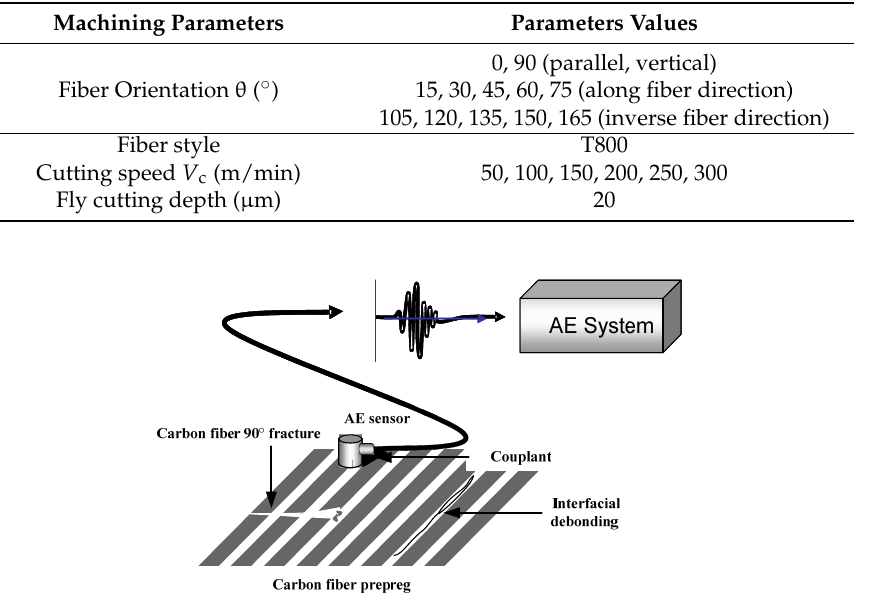
Figure 6. Acoustic emission monitoring of carbon fiber cutting.